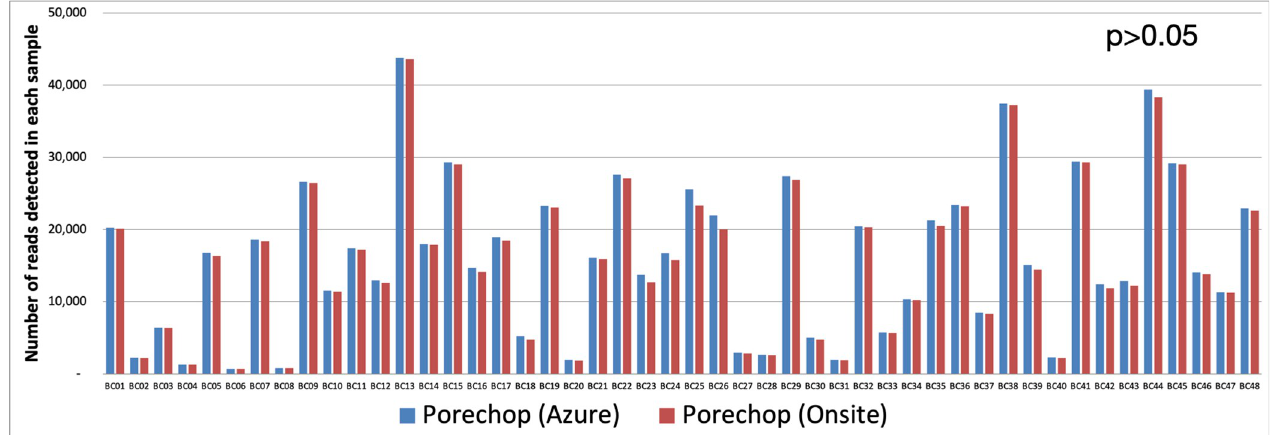
Fig 3. The number of reads detected in each sample on a 48-samples run. The blue colour bar represents the data obtained from Azure cloud analysis and the red colour bar depicts the data from manual analysis onsite.